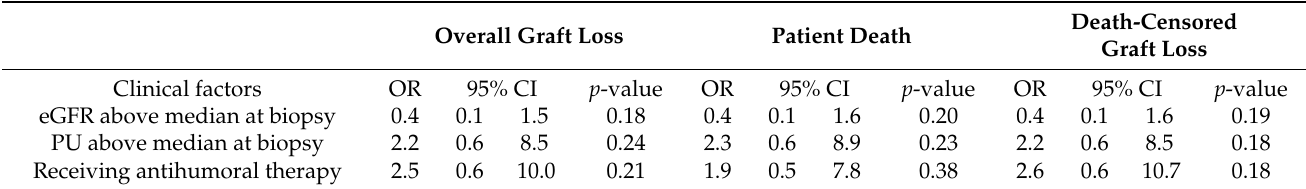
Table 4. Binary logistic-regression analysis of clinical factors associated with 5-year outcome after diagnosis of